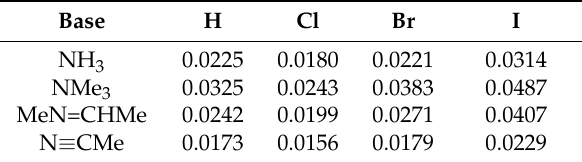
Table 5. AIM bond critical point density, ρ BCP (au), along Z ··· N noncovalent bond for ImZ + Lewis acids. Base H